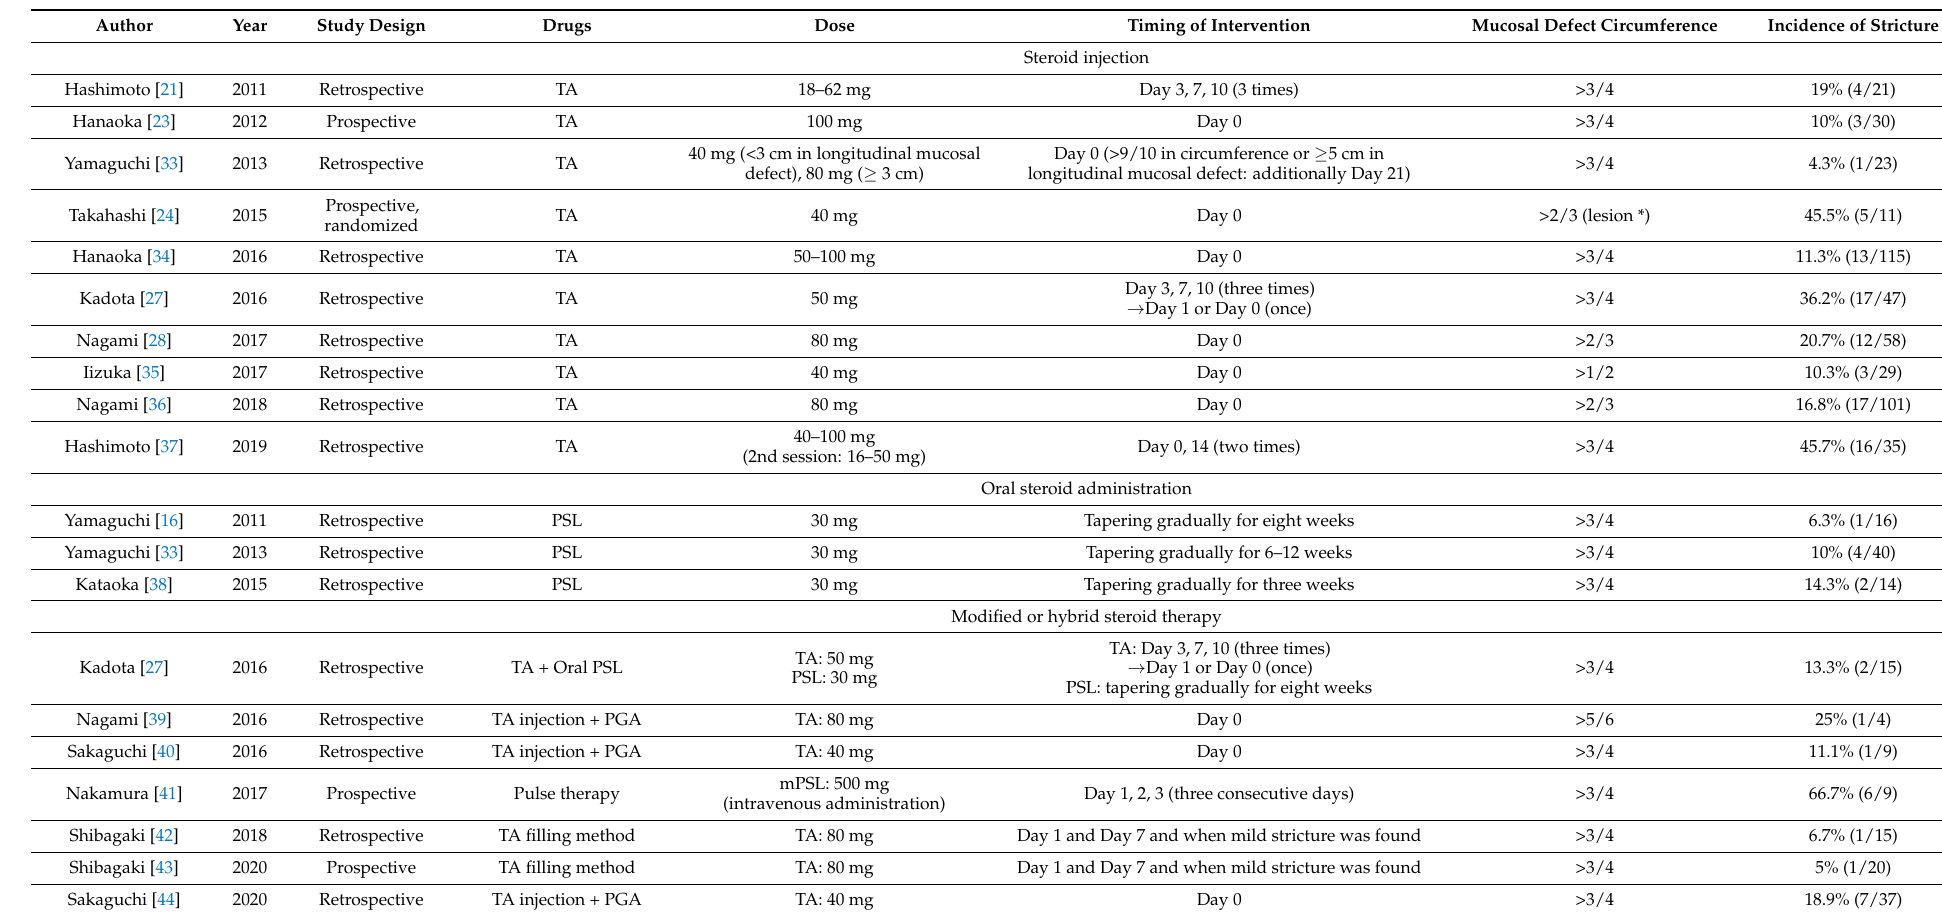
Table 3. Effect of preventive steroid therapy after non-total circumferential endoscopic submucosal dissection for esophageal squamous cell